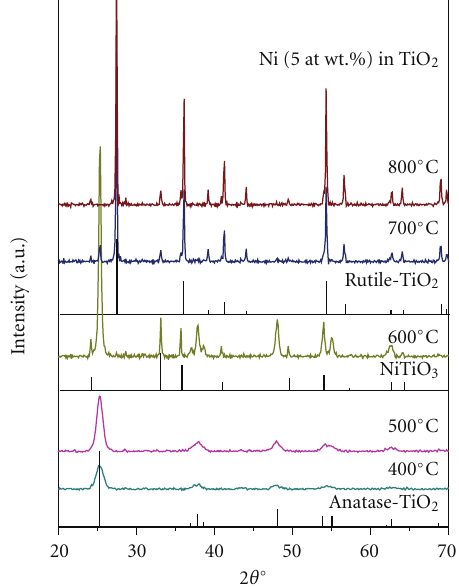
Figure 2: XRD patterns of 5 at. wt.% Ni-doped TiO 2 powder formed at 400 to 800 ◦ C for 6h. Rutile TiO 2 : ICDD File number: 03- 065-1118; anatase TiO 2 : ICDD File number: 03-065-5714; NiTiO 3 : ICDD File number: